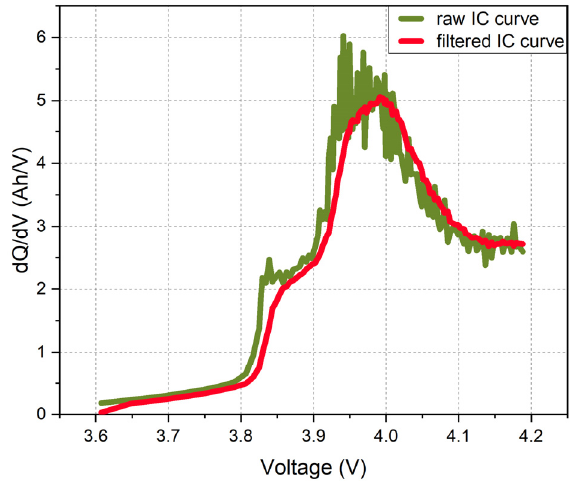
Figure 3. Smoothing results of IC curve.